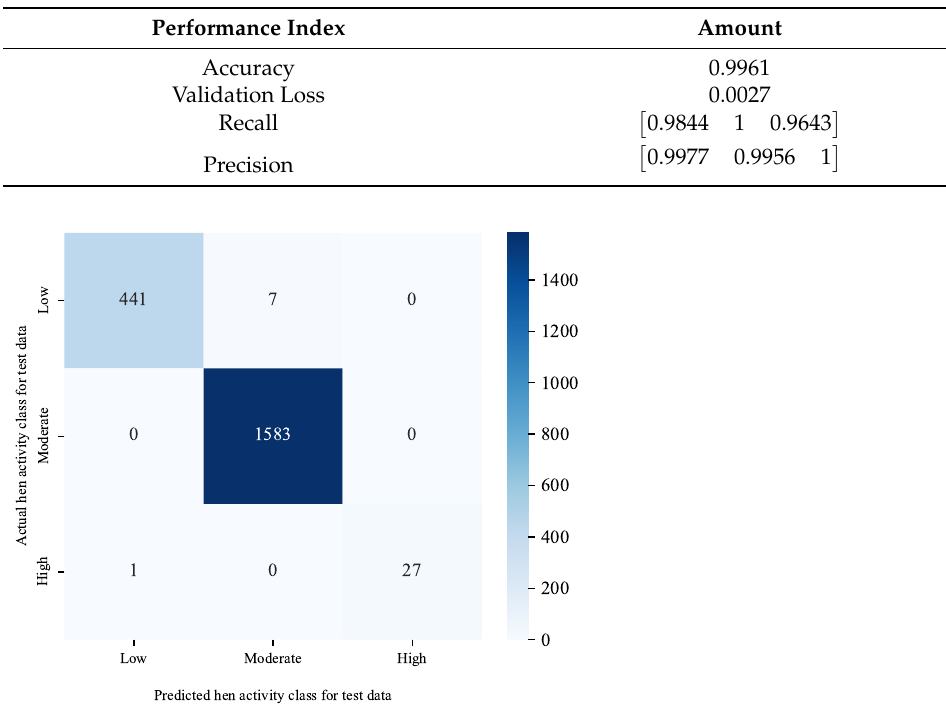
Table 7. Evaluation of the performance indices when the AVM data bundle of blue hen is used for both training and testing of the LeNet5 model.